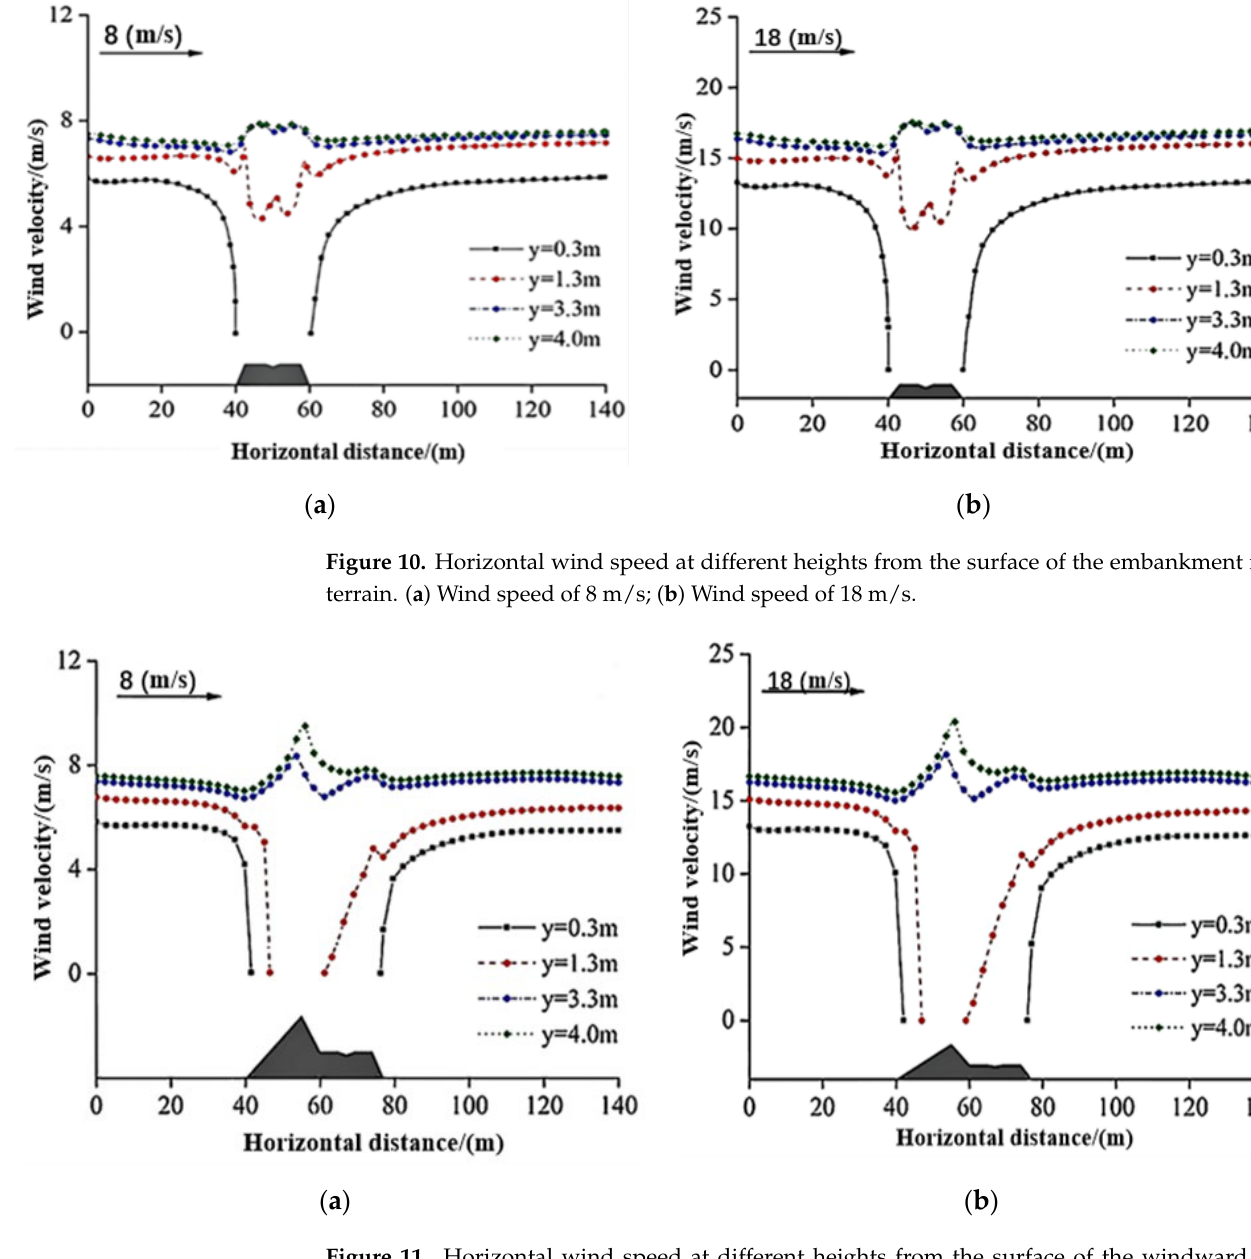
Figure 11. Horizontal wind speed at different heights from the surface of the windward dune embankment ( a )Wind speed of 8 m /s ( b )Wind speed of 18 m /s.